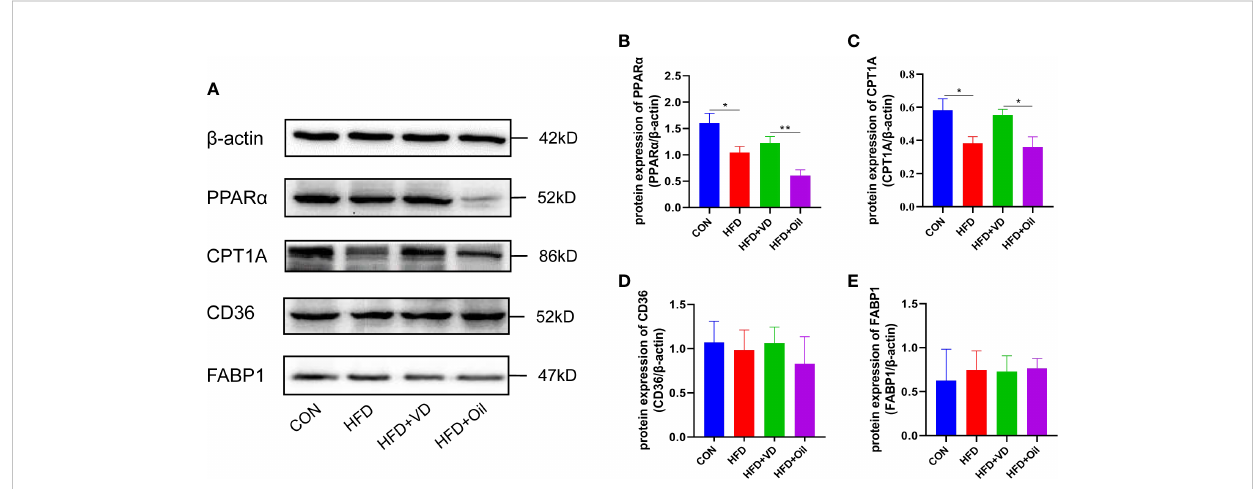
FIGURE 3 The effects of vitamin D on protein expression of lipid metabolism in NAFLD rats. (A) The expression of transcription factors involved in b -oxidation were detected by western blot. (B) PPAR a and (C) CPT1A were quali fi ed by b -actin. Lipid uptake proteins were detected by western blot. (D) CD36 and (E) FABP1 were quali fi ed by b -actin. The band intensity ratios were analyzed by ImageJ. Data were shown as the mean ± SEM. (n=8) *P < 0.05, **P <